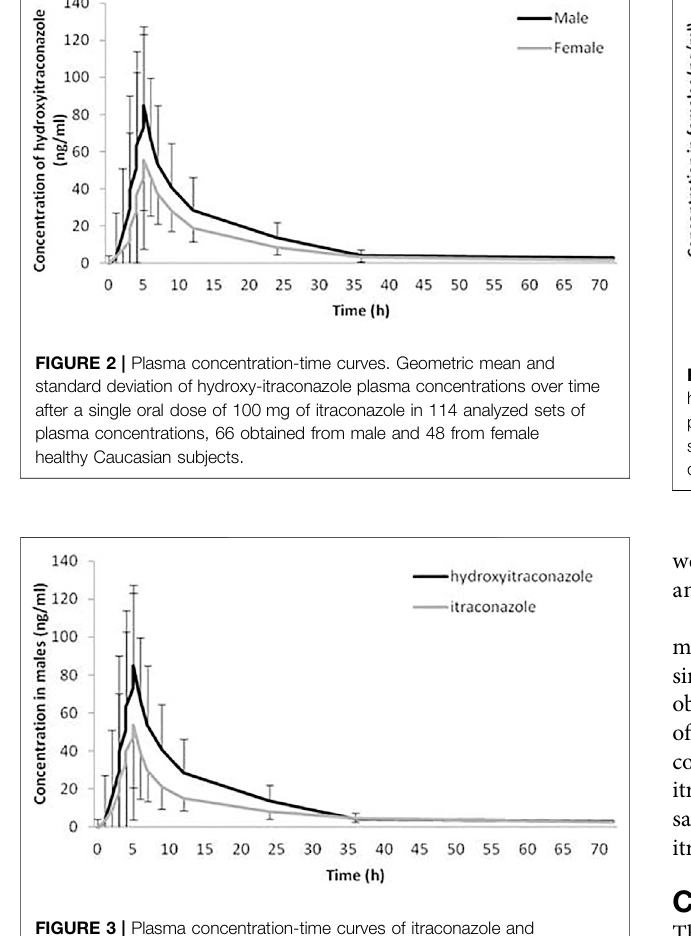
FIGURE 3 | Plasma concentration-time curves of itraconazole and hydroxy-itraconazole after a single oral dose of 100 mg of itraconazole providing 66 sets of plasma concentrations from male healthy Caucasian subjects. Data are presented as geometric mean and standard deviation.